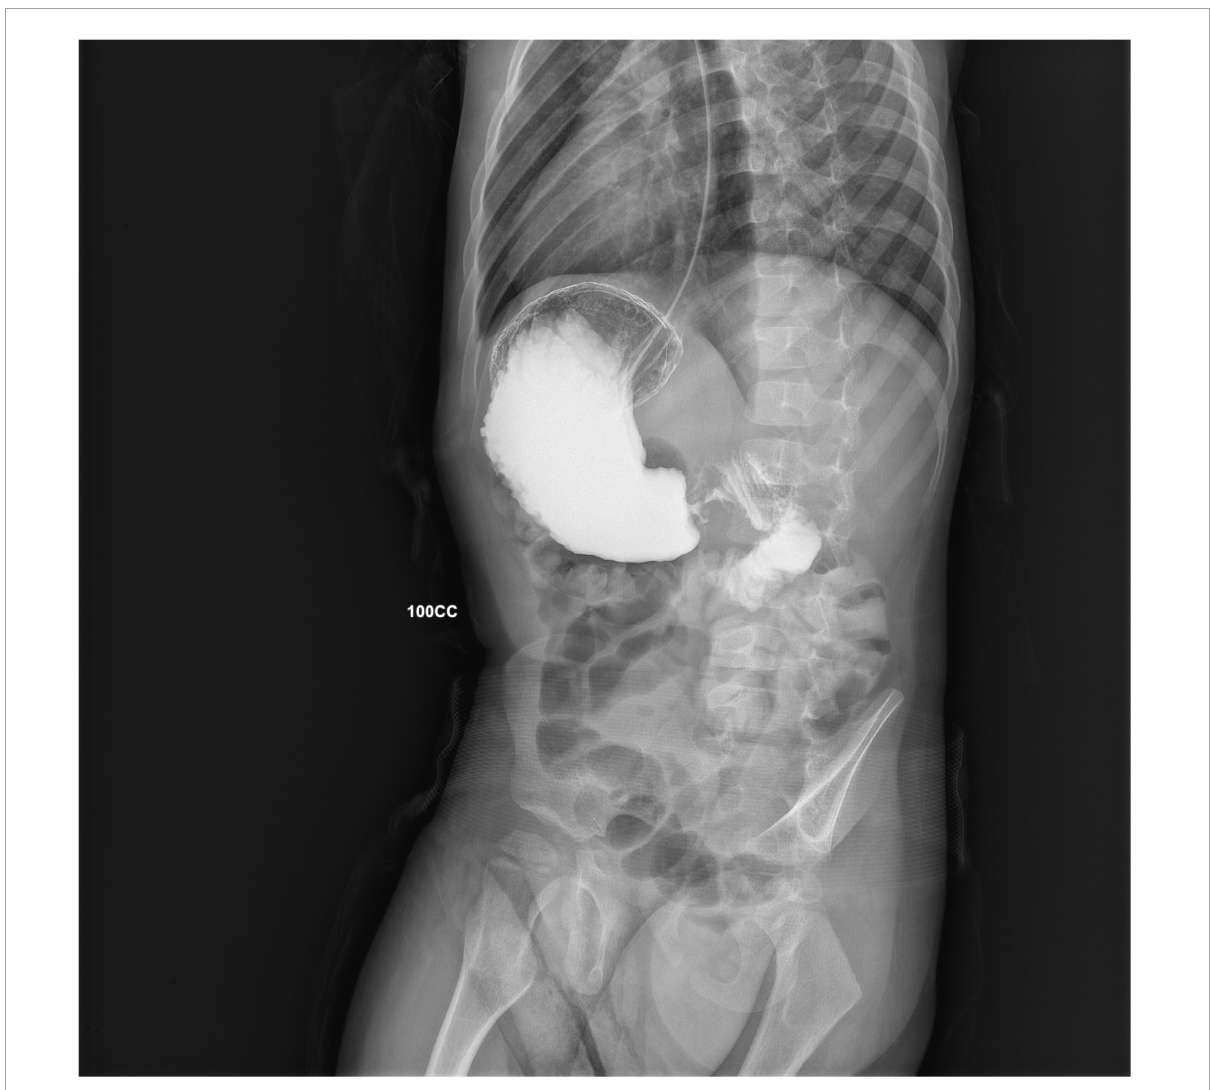
FIGURE1 A right anterior oblique projection from the GI series, showing accumulation of contrast medium into a dilated antrum ( shoulder sign ) and a narrow string-like pyloric channel ( string sign